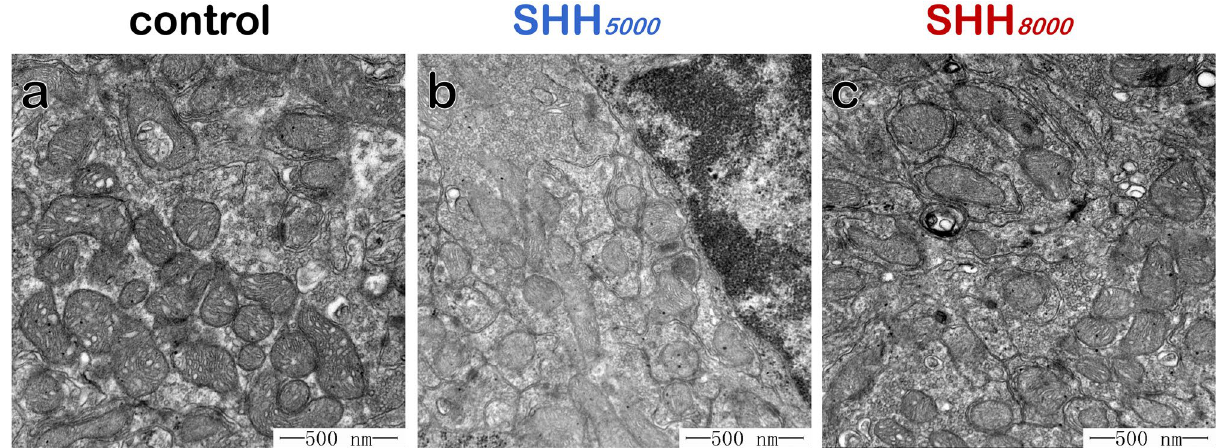
Figure 8. Representative transmission electron microscopy (TEM) images of cerebellar mitochondria. The circular, granular and tubular shaped mitochondria were frequently observed in the mice in normal control group ( a ), SHH 5000 group ( b ), and SHH 8000 group ( c ). Results showed that mitochondrial morphology in cerebellum did not significantly change after SHH treatment. Scale bars, 500 nm.